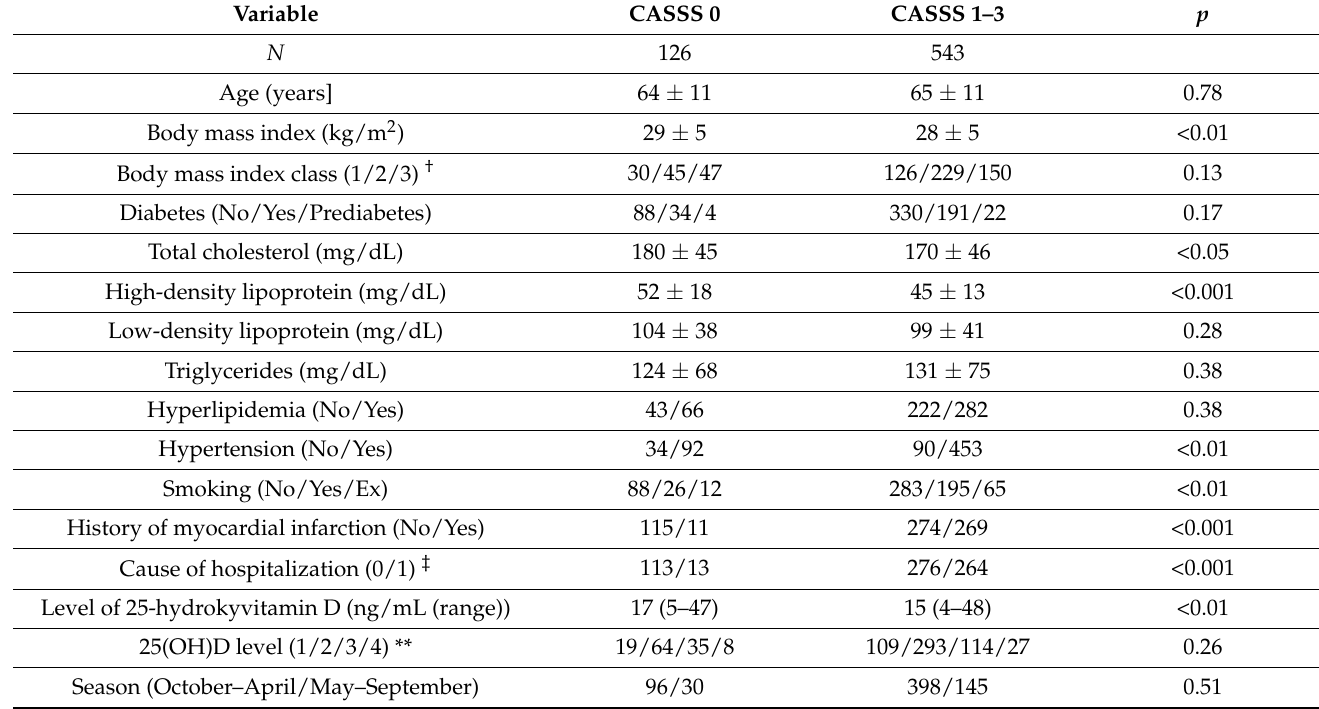
Table 3. Characteristics of the examined group divided according to degree of coronary atherosclero- sis (CASSS) into two